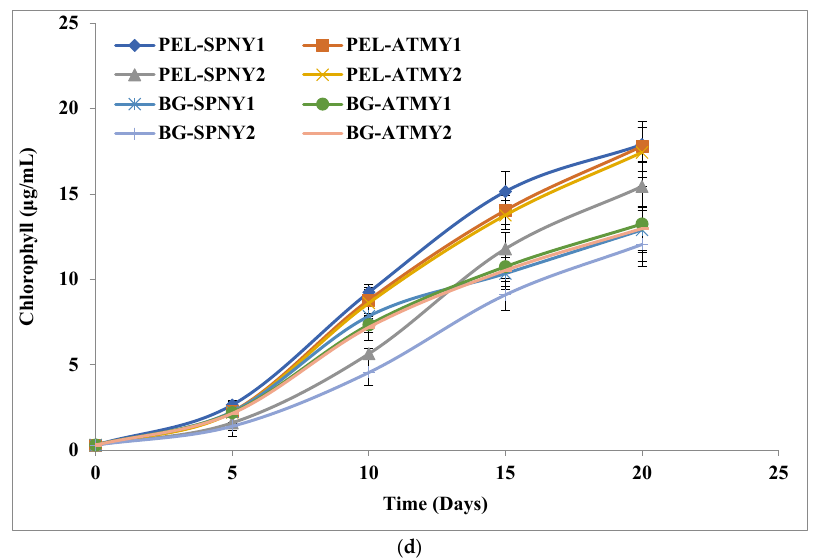
Figure 4. Biomolecules growth of C. pyrenoidosa at solar inclination angles of 32.9°: ( a ) carbohy ‐ drates; ( b ) protein; ( c ) lipid; ( d ) chlorophyll.